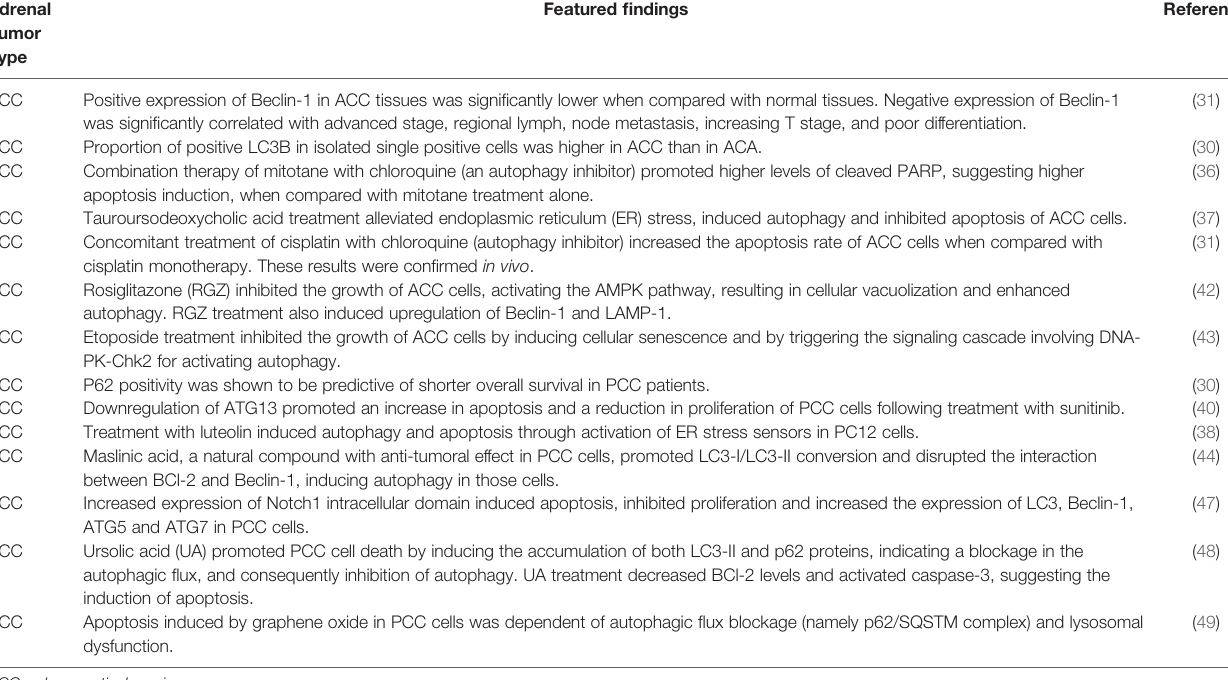
TABLE 1 | Autophagy modulation in adrenal tumors. Adrenal